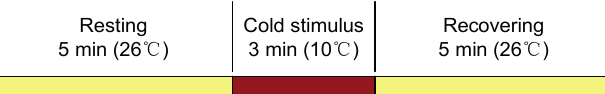
Figure 2. The procedure of the cold pressor